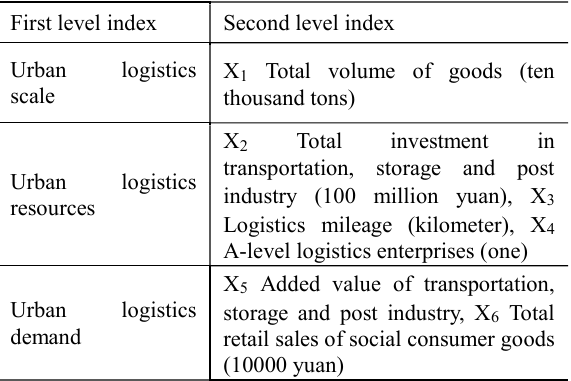
Table 1 The index system of urban logistics